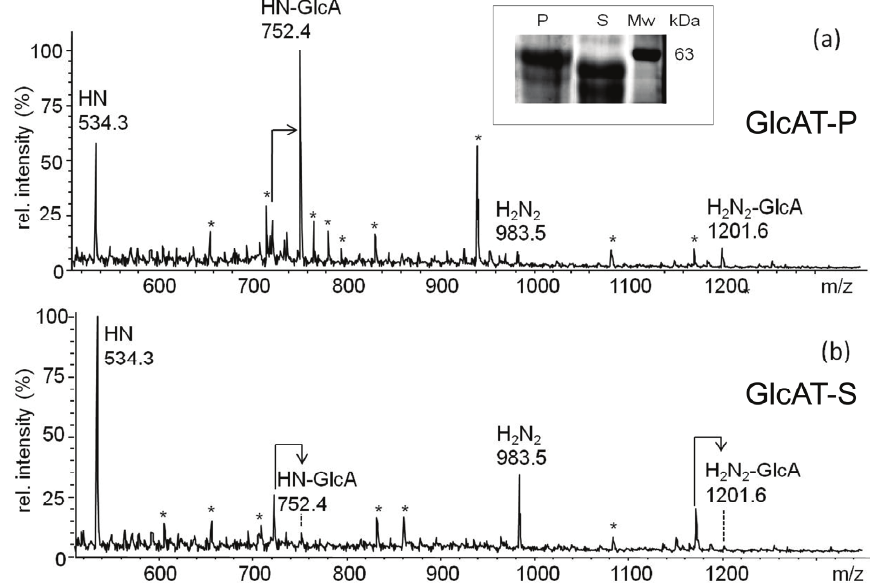
Figure 7. ( a ) MALDI mass spectrometric analysis of methylated O -glycan alditols derived from in vitro glucuronylated asialo-fetuin (dGlcAT-P sol). The mass spectrum reveals glucuronylated mucin-type glycan chains at m / z 752 (HN-GlcA, core 1) and 1201 (H2N2-GlcA, core 2). ( b ) MALDI mass spectrometric analysis of methylated O -glycan alditols derived from in vitro glucuronylated asialo-fetuin (dGlcAT-S sol). The mass spectrum shows the same pattern of glycan alditols as in ( a ), but the ratio of glucuronylated O -glycan chains vs. non-glucuronylated chains is significantly lower. (*: matrix signals and non-identified contaminants) The insert shows a coomassie-stained SDS-Gel of asialofetuin glucuronylated in vitro by dGlcAT-P (lane P) or dGlcAT-S (lane S). The difference in the apparent molecular masses corresponds to the higher activity of dGlcAT-P towards O -glycans as shown in ( a , b ). Short notation of glycan structures: H, hexose; N, N -acetylhexosamine; GlcA, glucuronic acid.